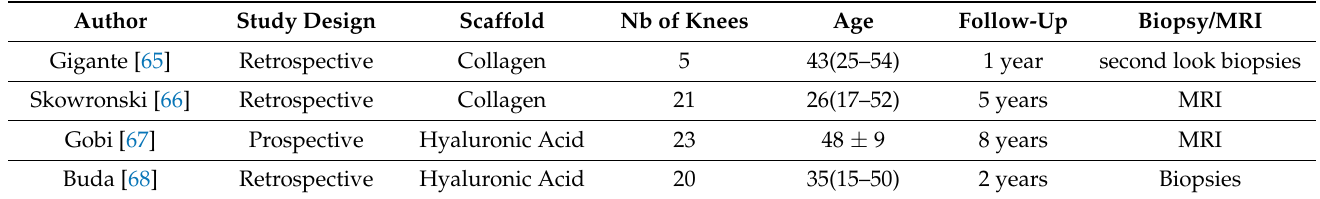
Table 3. Clinical studies with BMAC loaded in